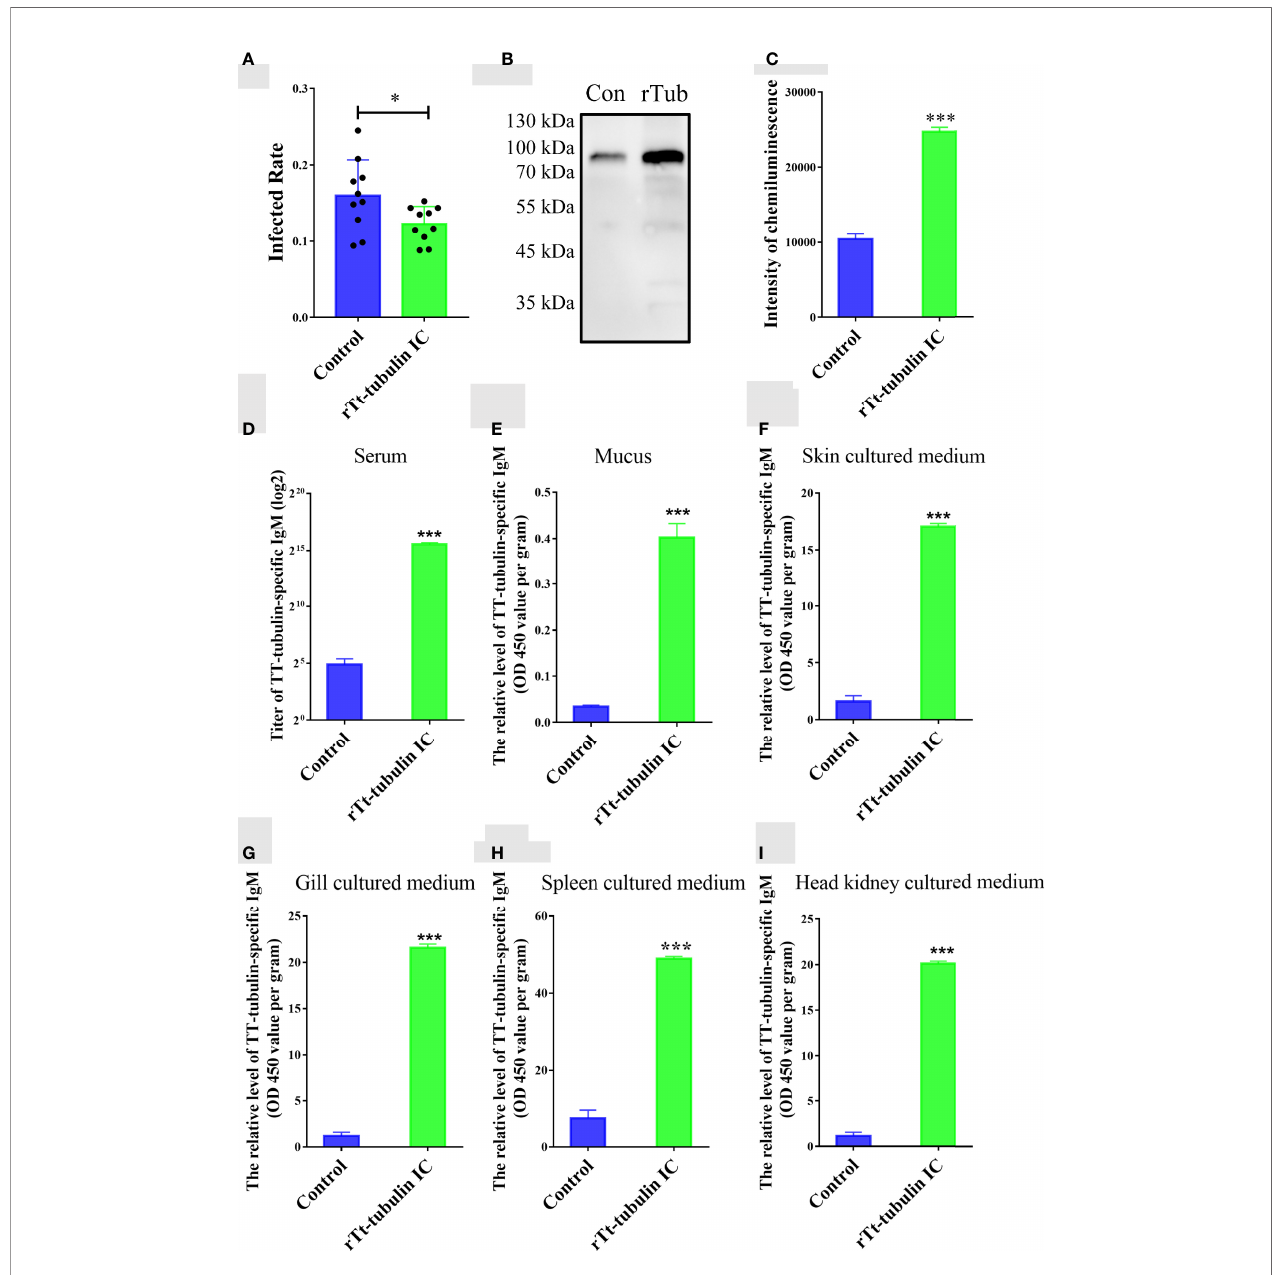
FIGURE 6 | Tt-tubulin provides immune protection for grouper against C. irritans infection. (A) C. irritans infection rate of rTt-tubulin – immunized groupers (n = 10). (B) Western blot analysis and (C) densitometric analysis of parasite-binding IgM in sera from control and rTt-tubulin – immunized groupers at 72 h after C. irritans infection (n = 3). (D – I) ELISA detection of the anti – rTt-tubulin IgM antibody in serum (D) , mucus (E) , skin culture medium (F) , gill culture medium (G) , spleen culture medium (H) , and head kidney culture medium (I) (n = 5). Signi fi cant differences are represented as * (p < 0.05) and *** (p <